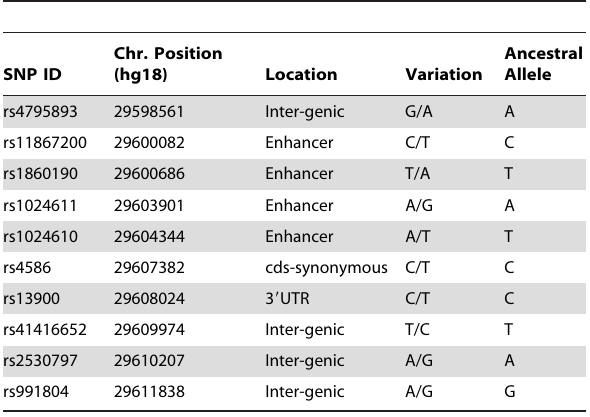
Table 2. Chromosomal positions and genomic location of the CCL2 locus HapMap SNPs.